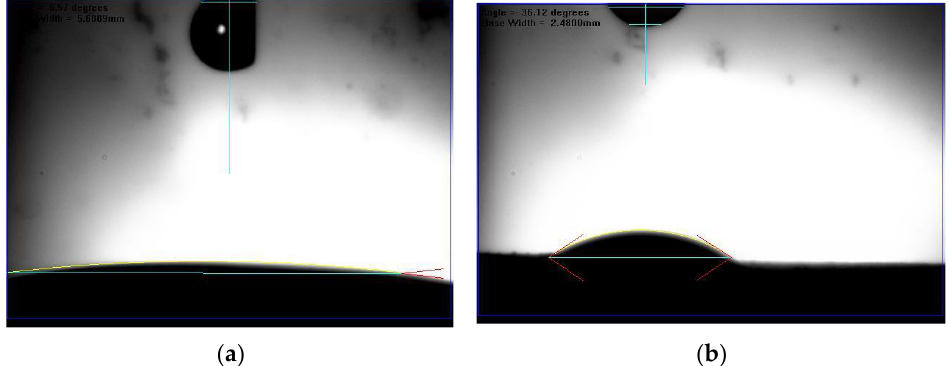
Figure 2. Pictures taken during contact angle measurements for core samples 1 ( a ) and 2 ( b ) using 0.9% NaCl.